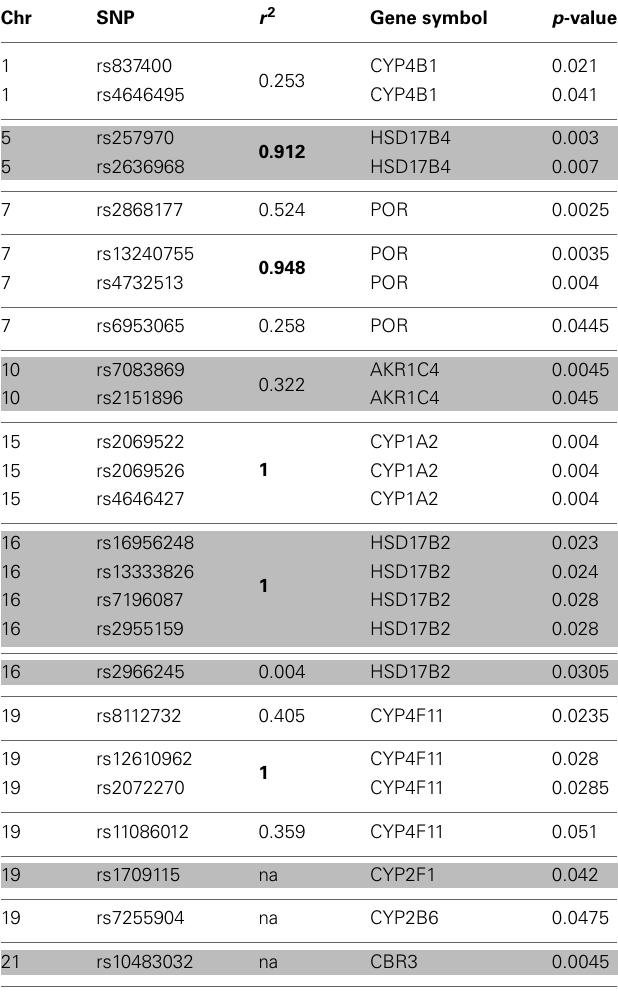
Table 2 | Top 25 SNP identified through single SNP tests of